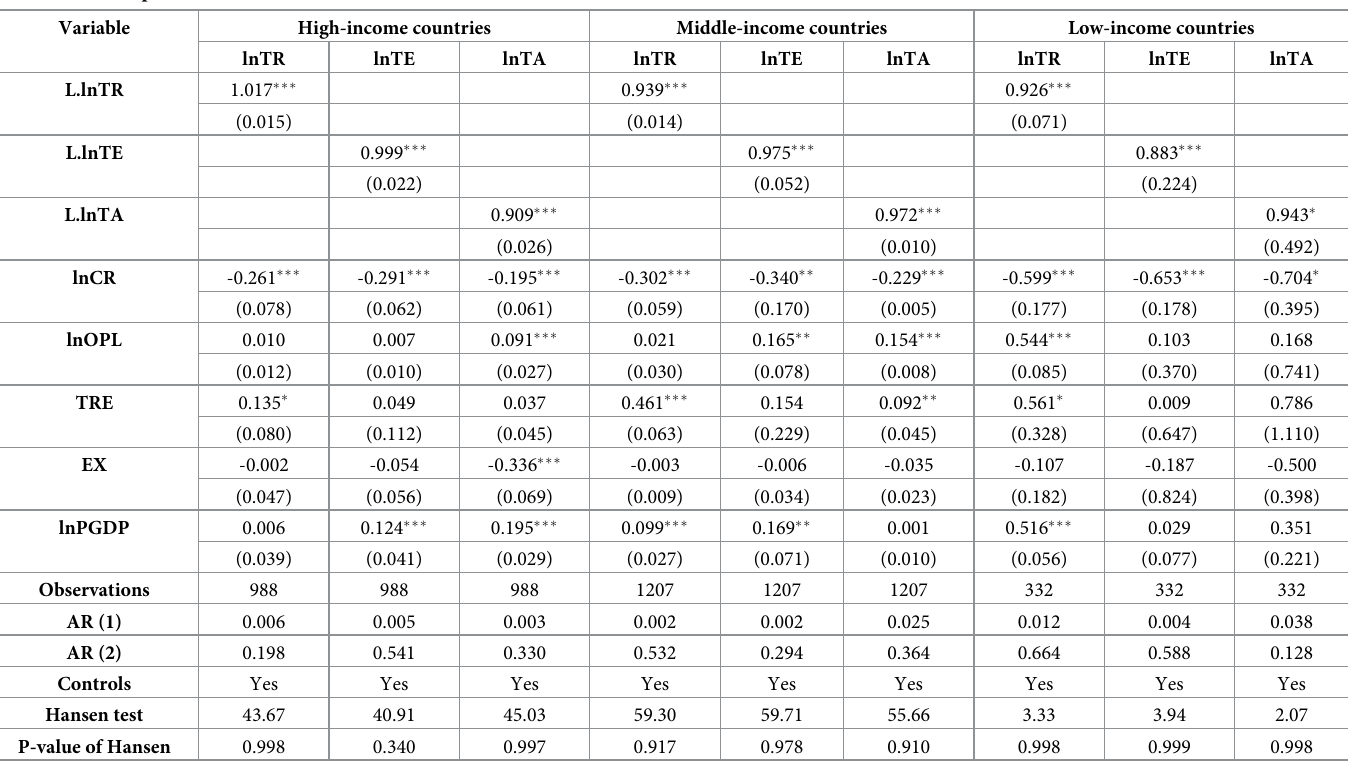
Table 10. The impact of CR on tourism in countries with different income